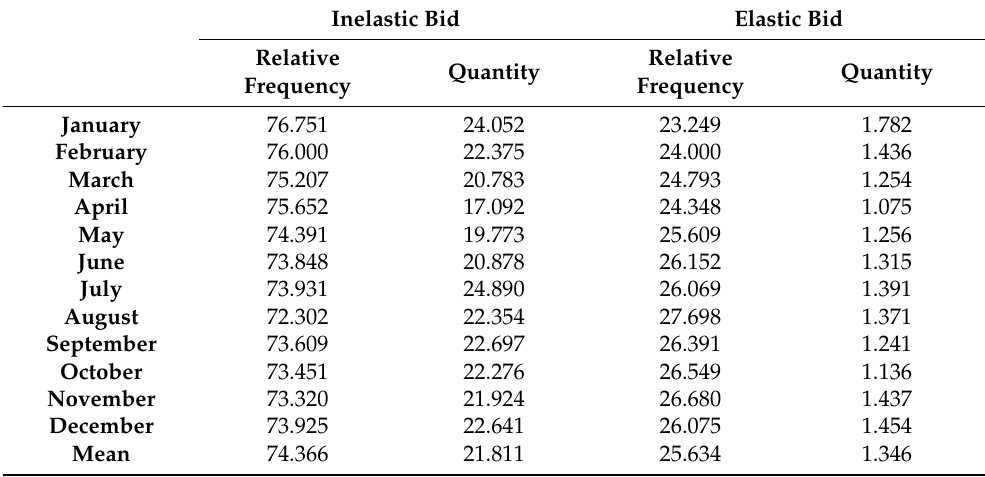
Table 3. Offer to Purchase (BID): Monthly Relative Frequency and Total Quantity of Inelastic and Elastic Bids.